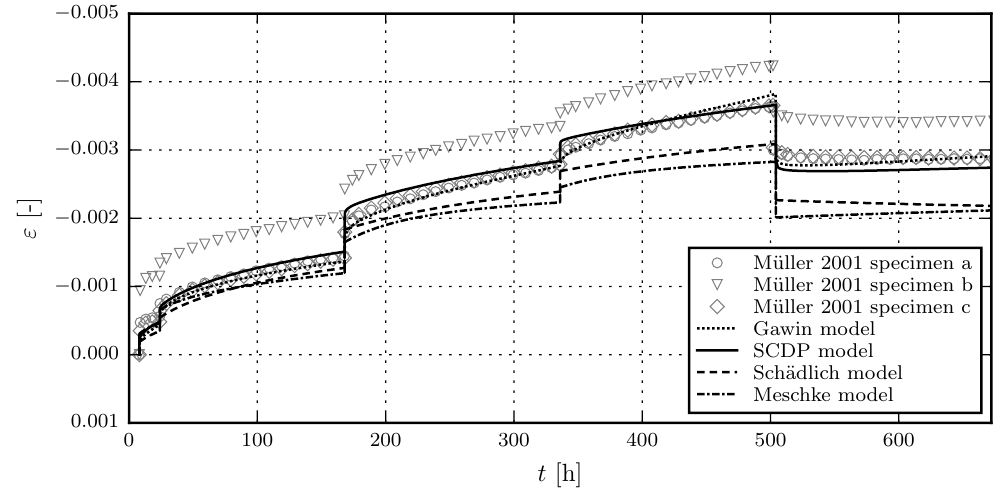
Figure 8. Evolution of the total strain in creep tests on unsealed specimens: Validation of the shotcrete models by means of the test data from creep test series 3 by Müller